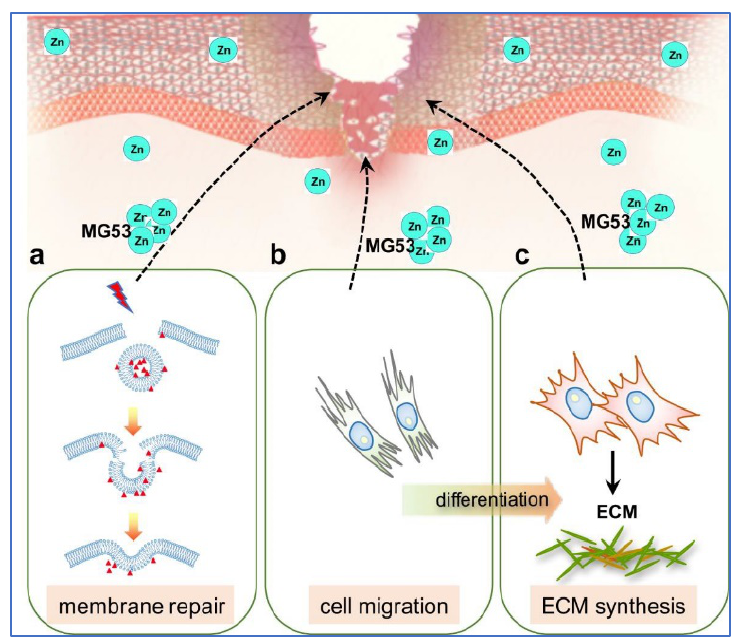
Figure 2. Proposed roles of zinc in MG53 mediated wound healing process. MG53 exists as intrinsic intracellular vesicles which could be secreted into blood circulation as a myokine to mediate wound healing. In response to dermal injury, MG53 could exert the following functions. ( a ) MG53-containing vesicles nucleate the cell membrane repair machinery and trafficking to damaged cell membrane to protect against acute membrane injury of keratinocytes and fibroblasts; ( b ) MG53 mediates cytoskeletal stress fibre remodelling to promote fibroblasts migration to the wound sites; and ( c ) MG53 regulates TGF β signalling to modulate trans-differentiation of fibroblasts into myofibroblasts and suppresses deposition of ECM proteins during tissue remodelling stage of wound healing. Zinc is proposed to bind to MG53 on its two zinc-binding sites and modulates MG53-mediated wound healing process (Modified from JBC 290(40): 24592). MG53: Mitsugumin 53; ECM: extracellular matrix; TGF β : transforming growth factor- β.